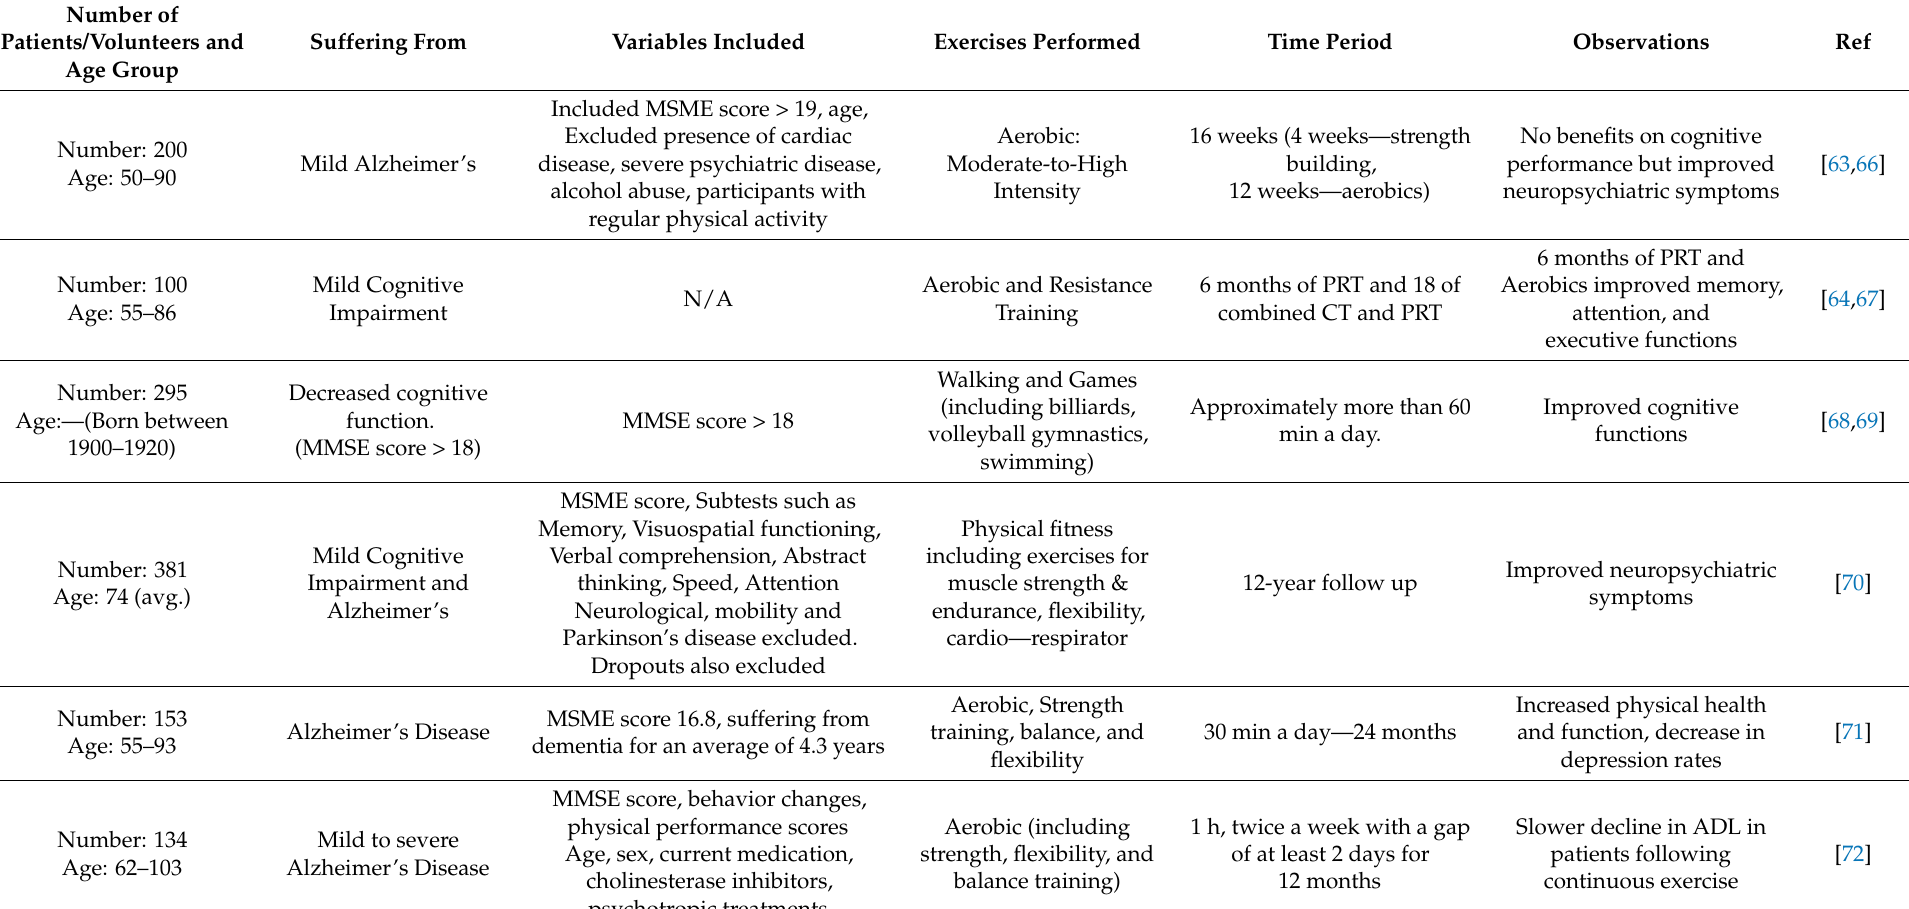
Table 3. Exercise and Alzheimer’s disease in